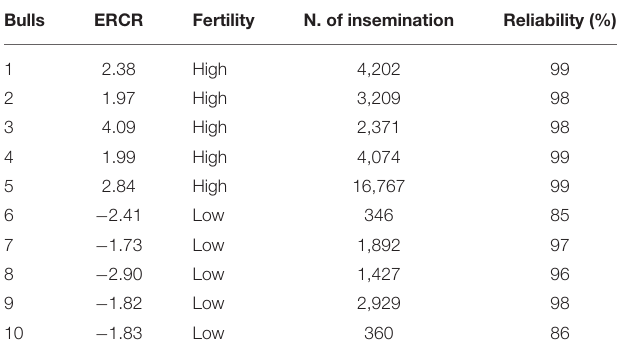
TABLE 1 | Field fertility details of the bulls involved in the study.